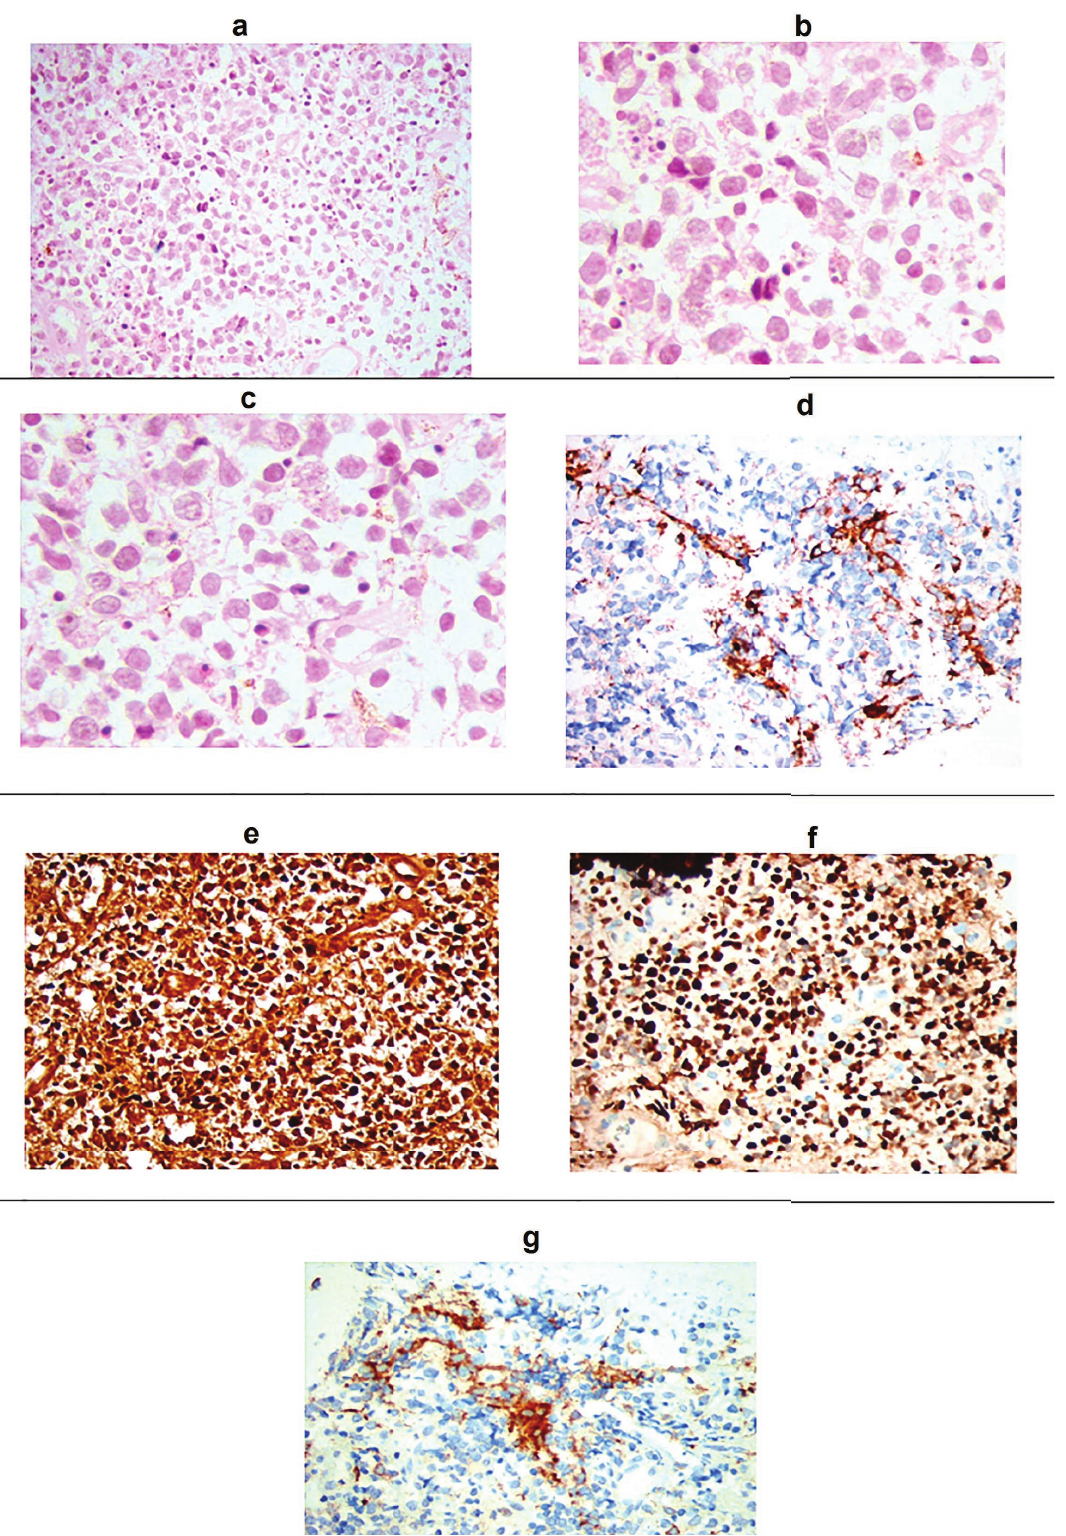
Figure 6. Histopathologic images (a) Epithelioid and spindle-shaped neoplastic cells with apoptotic bodies and mild scattered melanin pigments [hematoxylin and eosin stain (H&E) × 400]; (b,c)-Dysplastic tumor cells mainly of epithelioid type with large nuclei, prominent nucleoli, and apoptosis, H&E × 1000, higher magnification; Patchy immune-reactivity to HMB45 (d), strong immune- reactivity to S100 (e) and Ki67 (f), magnification × 400; (g) Patchy immune-reactivity to melan-A, magnification × 400.